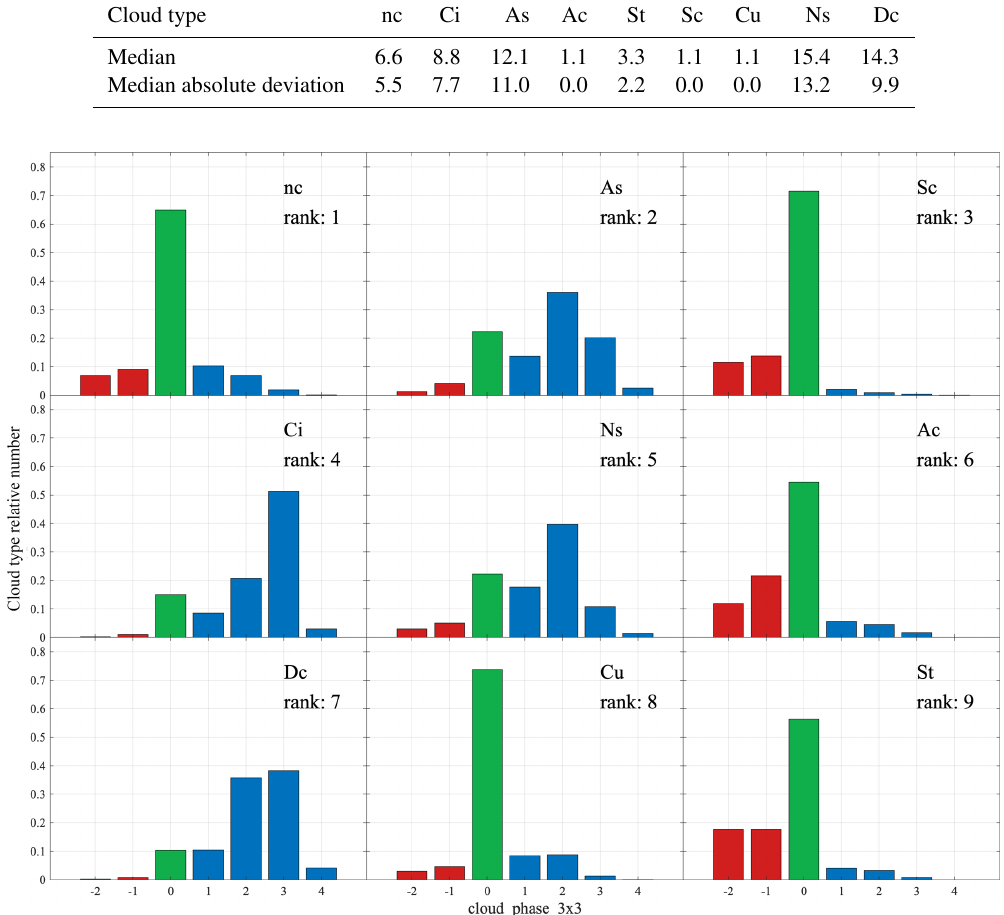
Figure 7. AIRS cloud_phase_3x3 histograms for cloudy sky with one cloud type (i.e., all CloudSat profiles have the same cloud type and no clear sky). The red, green, and blue bars indicate liquid, undetermined, and ice phase, respectively. Each histogram sums to 1.0 and does not show how many counts relative to another histogram. Relative counts could be inferred from the percentages listed in the second to left column of Table